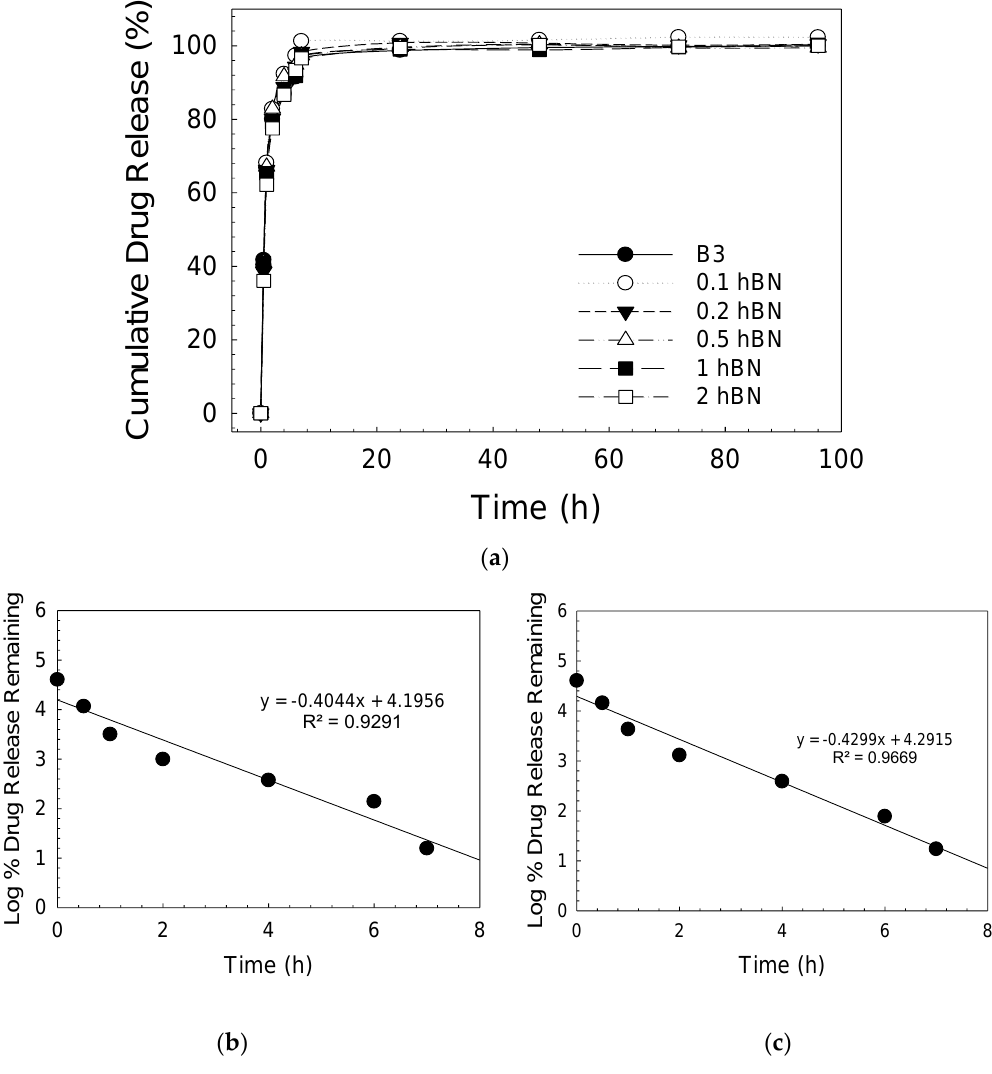
Figure 8. ( a ) Cumulative gentamicin sulfate release curve; graphs showing the first order drug release for ( b ) bare B3, ( c ) 2 hBN-B3. Table 1. Gentamicin sulfate release kinetics model parameters. K 0 , K 1 , and K H are zero order, first order, and Higuchi model rate constants. t is time, and C 0 is the initial concentration of the drug. Sample